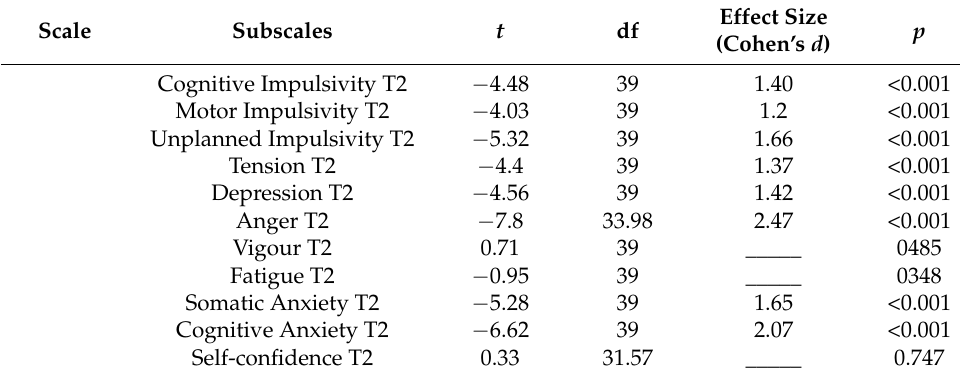
Table 2. Independent sample t -tests for T2 measures in the intervention and control groups and effect sizes.